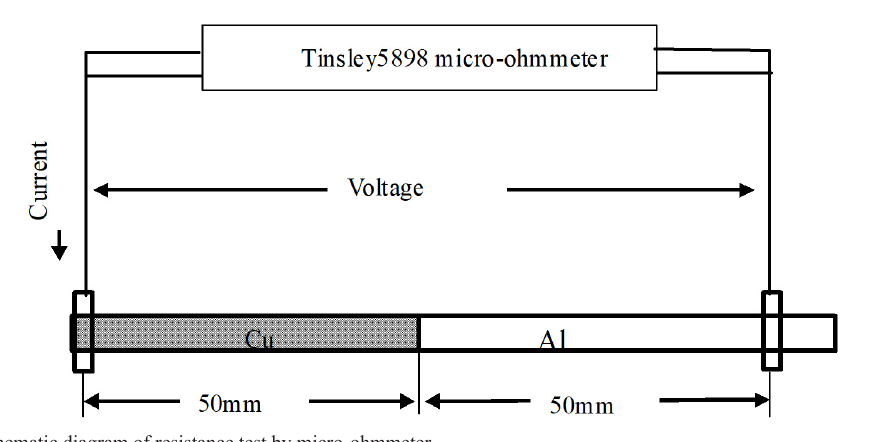
Figure 2. Schematic diagram of resistance test by micro-ohmmeter.